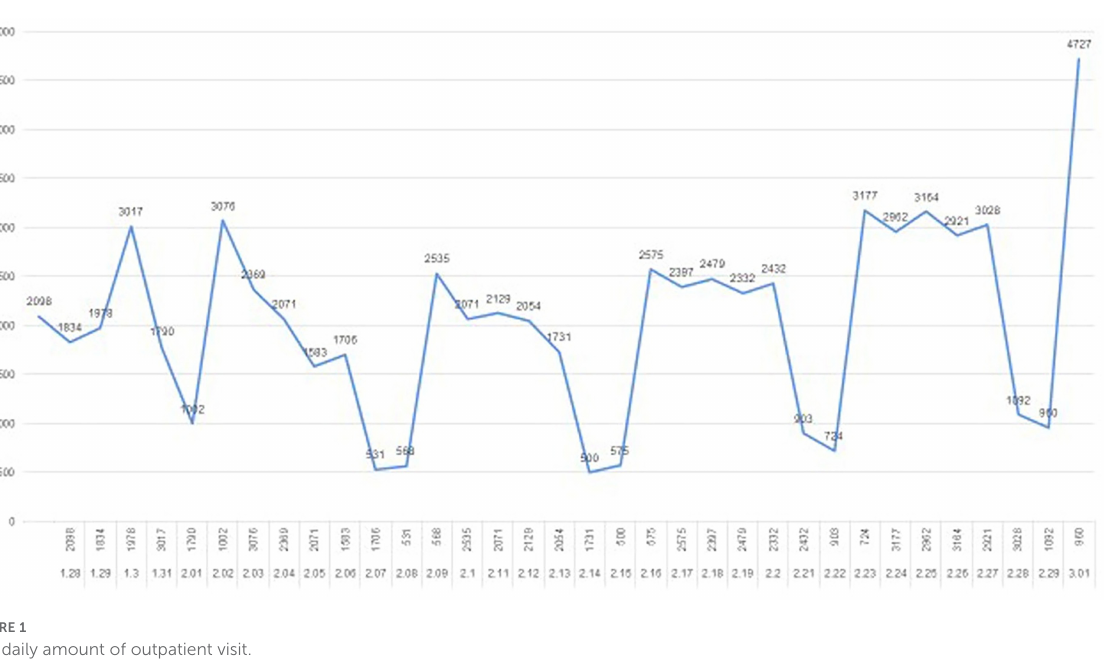
FIGURE1 The daily amount of outpatient visit.